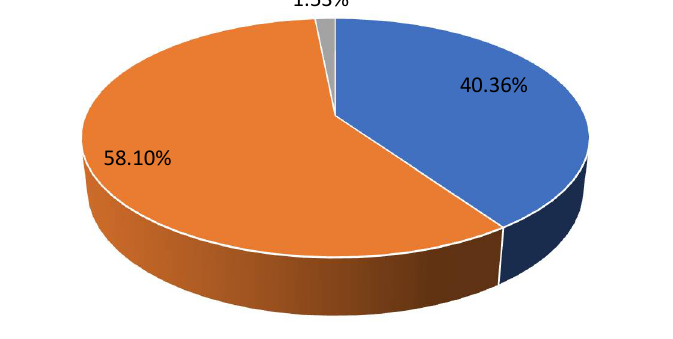
Figure 4. Operational expense breakdown.